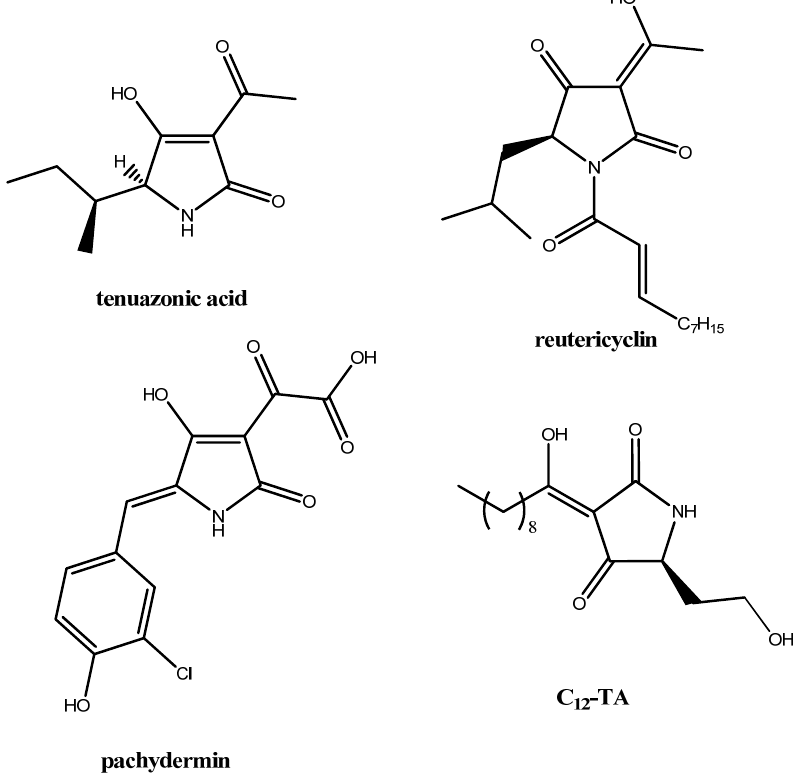
Figure 1. Naturally occurring tetramic